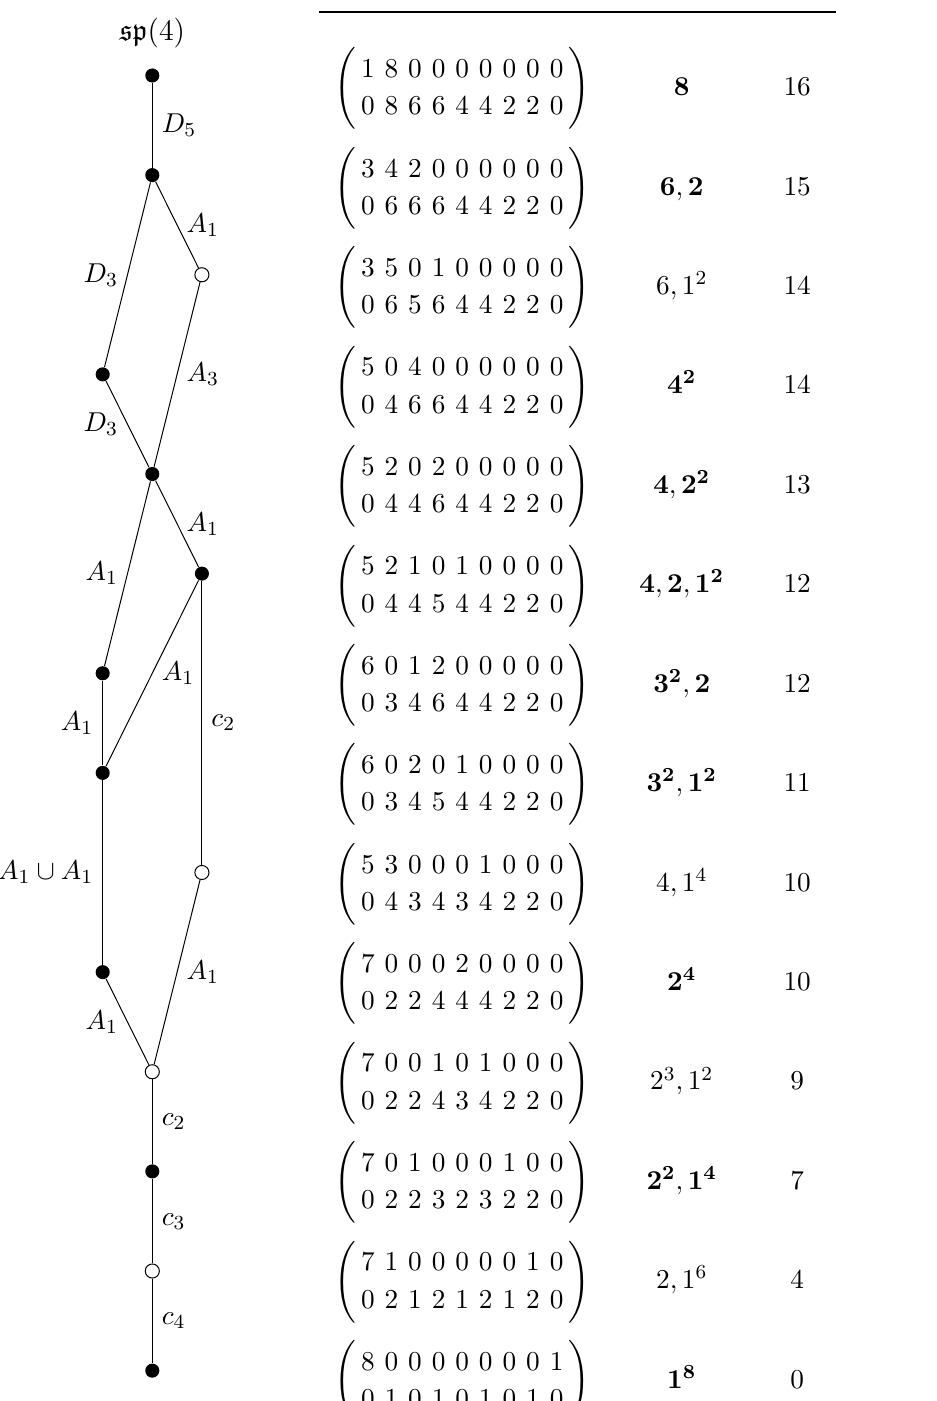
Table 22. Results obtained applying the matrix formalism to sp (4).